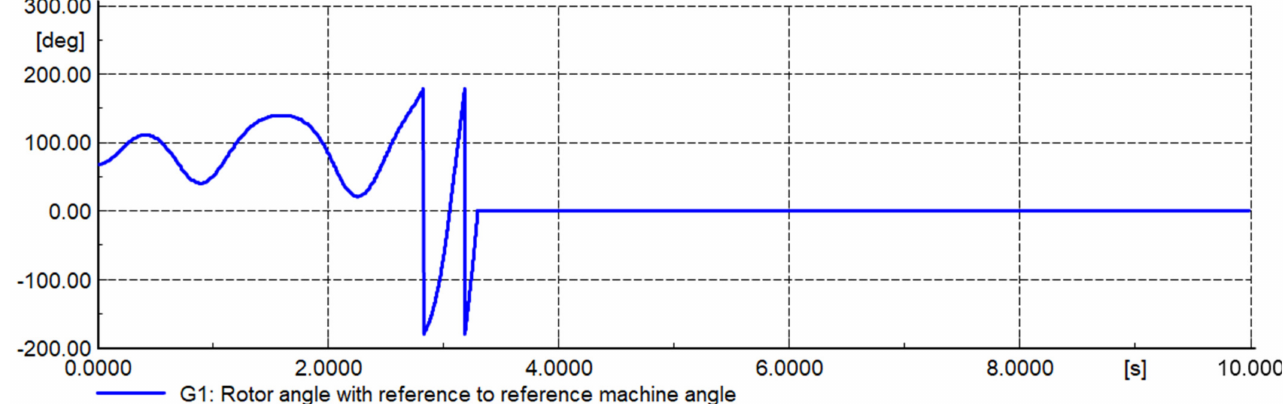
Figure 19. Test 2 : Rotor angle of G1 generator with OOS relay on CCT-1 line.